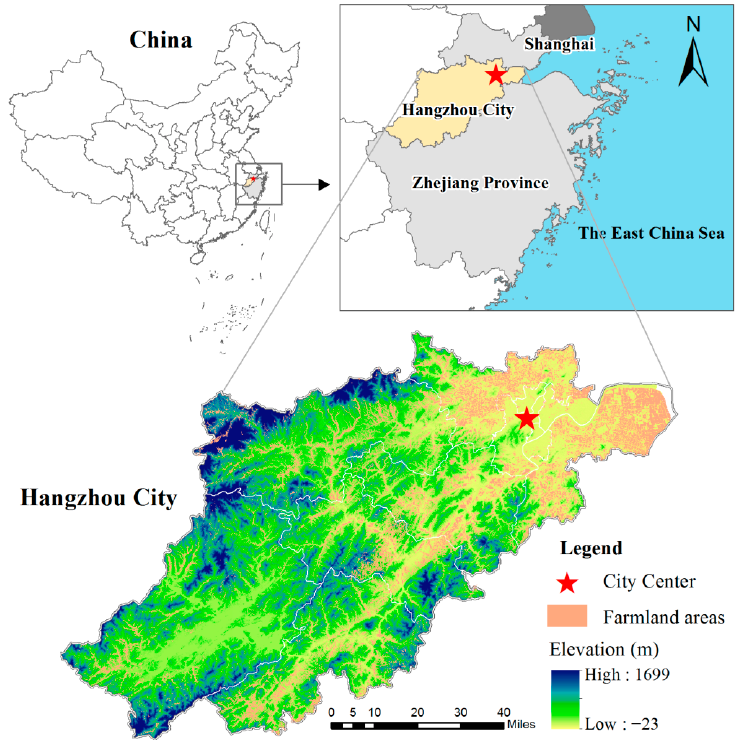
Figure 1. Location of the study region.